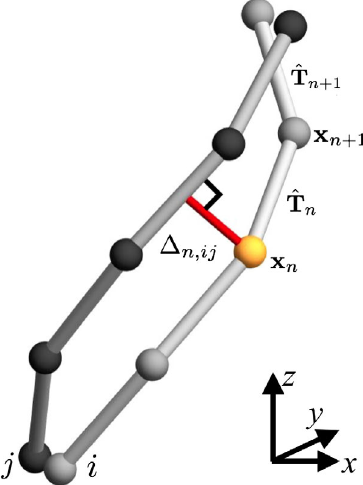
FIG. 3. Discrete model of cohesive filaments and their inter- actions, for Eqs. (17) and (18). The distance of closest contact (red line) represents the true separation between filaments i and j